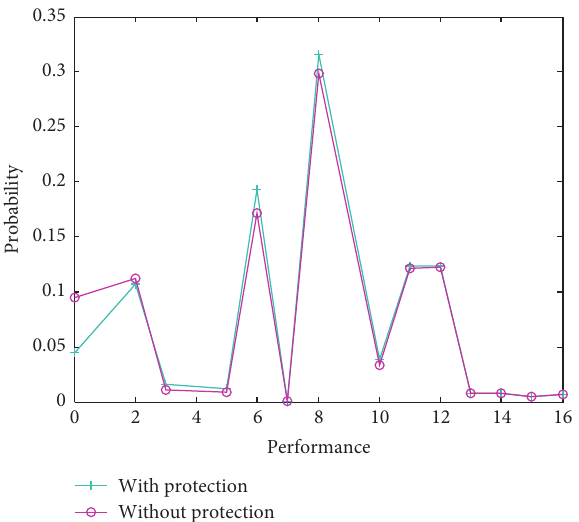
Figure 3: Comparison of UGF expression of the whole system with and without protection.